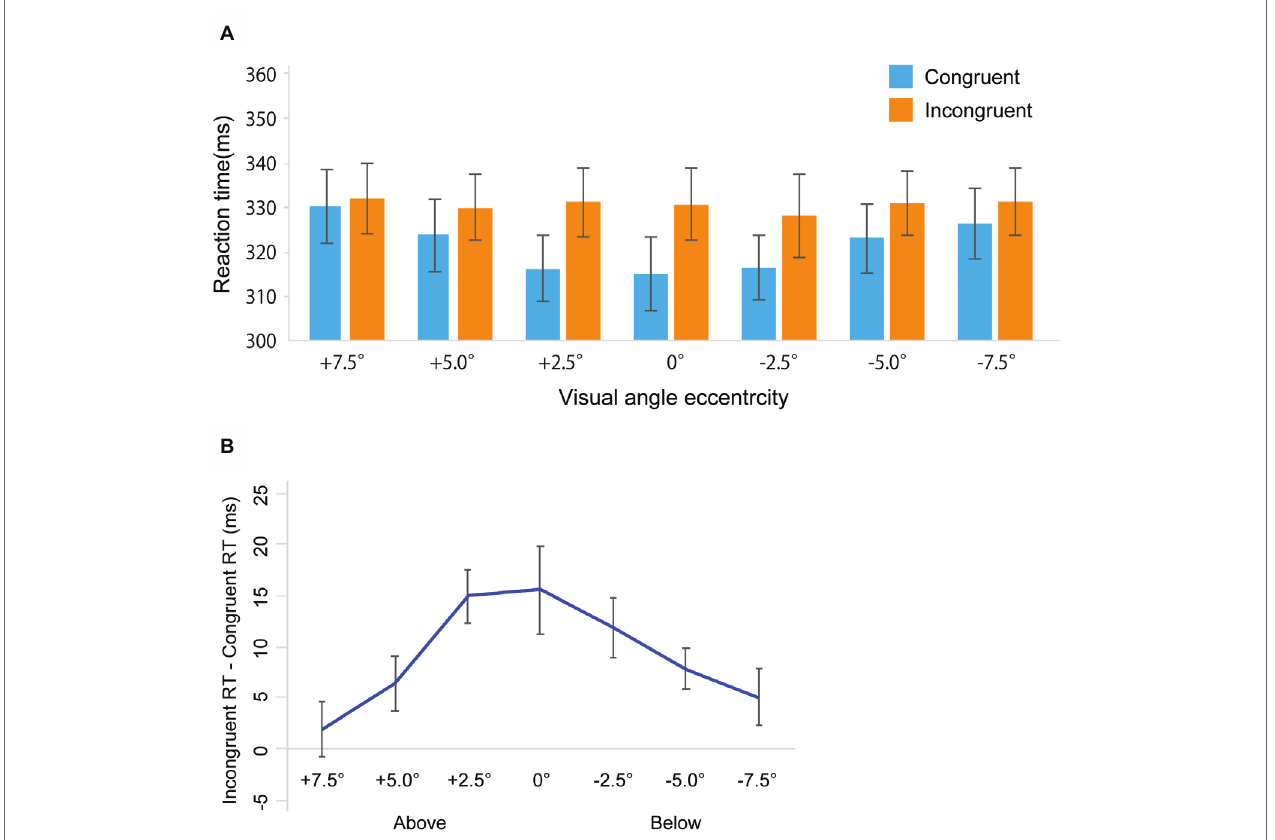
FIGURE 2 | Results in Experiment 1. (A) Mean of (individual) median reaction time (ms). (B) The results of the magnitude of the gaze cuing effect (incongruent RT-congruent RT). The error bars represent standard error of